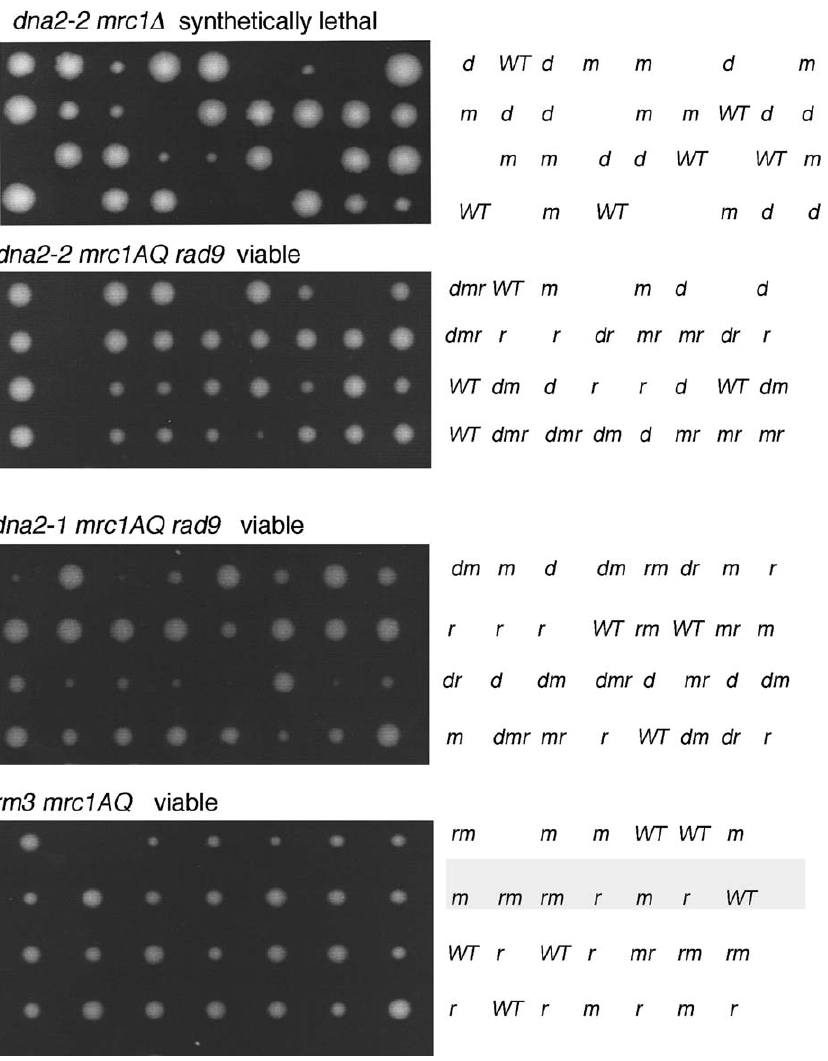
Figure 6. Separation-of-Function Checkpoint Mutants mrc1AQ and rad9 D Are Not Synthetically Lethal with dna2 or rrm3 D Mutants mrc1 D experiments were carried out in the isogenic 4741 strain and are listed in Table S4. mrc1AQ experiments were carried out in strains isogenic with W303 RAD5 þ . Panel 1 (top): segregants from a DNA2/dna2–2 MRC1/mrc1 D diploid. Segregants are isogenic with 4741 . d, dna2–2; m, mrc1 D . Panel 2: segregants from a MRC1/mrc1AQ RAD9/rad9 D DNA2/dna2–2 diploid. d, dna2–2; m, mrc1AQ; r, rad9 D . Panel 3: segregants from a DNA2/dna2–1 MRC1/mrc1AQ RAD9/rad9 D strain. d, dna2–1; m, mrc1AQ; r, rad9 D . Panel 4 (bottom): segregants from a RRM3/rrm3 D MRC1/mrc1AQ diploid. m, mrc1AQ; r, rrm3 . DOI: